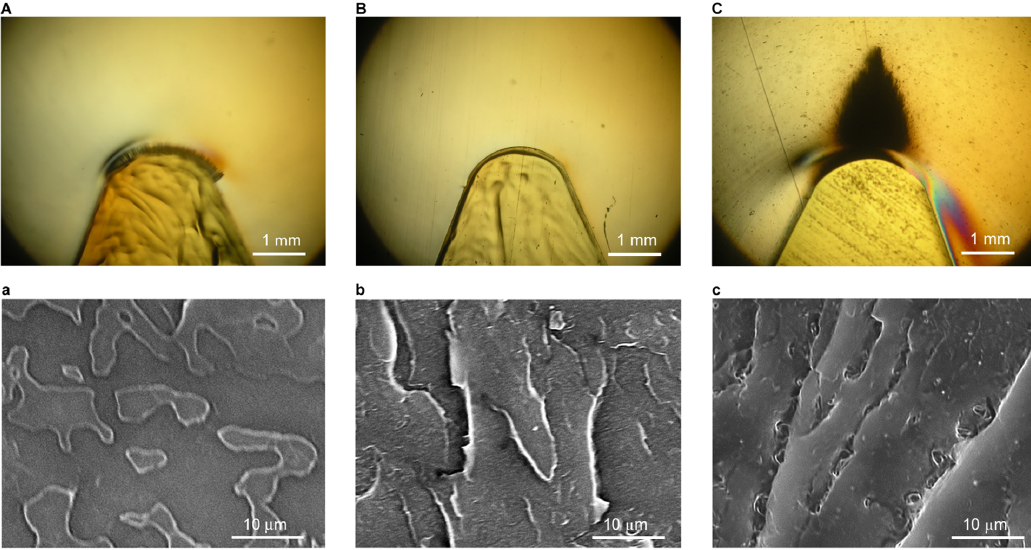
Figure 9. Polarized light micrographs of ( A ) PMMA, ( B ) PR10, and ( C ) PSR10. SEM images of ( a ) PMMA, ( b ) PR10, and ( c ) PSR10 in regions of plastic deformation at the notch tips.